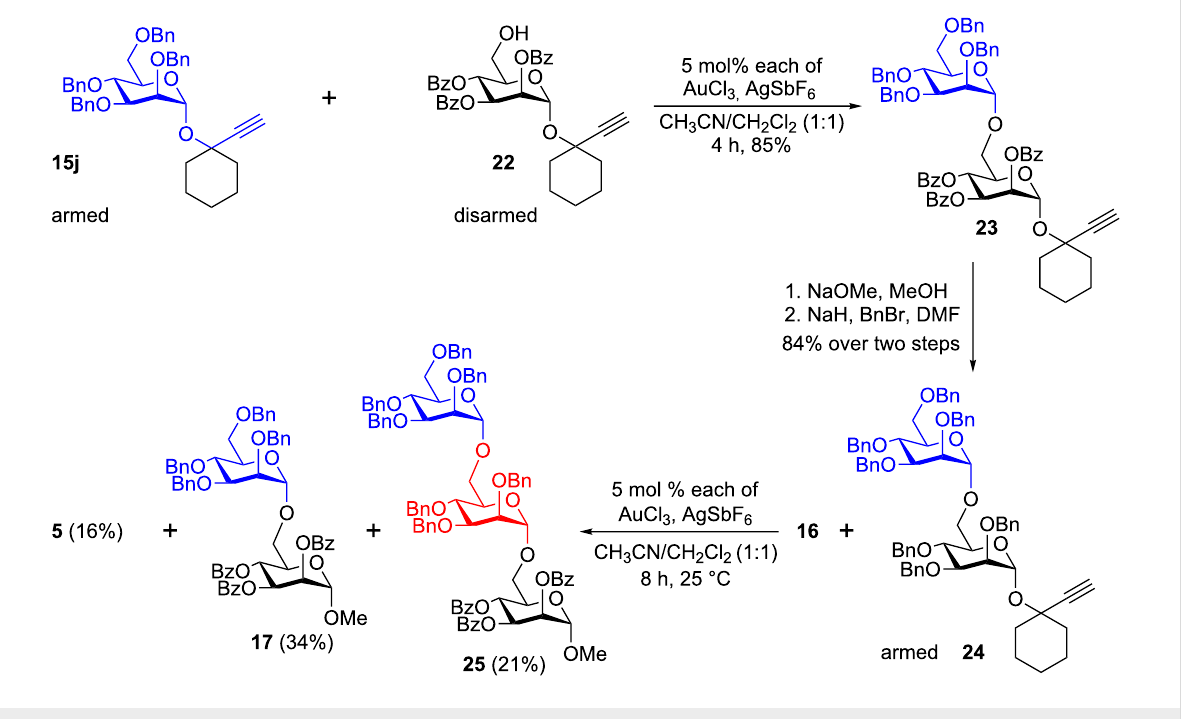
Scheme 5: Gold-catalyzed glycosidation at ambient temperature for the synthesis of trimannoside 25 .